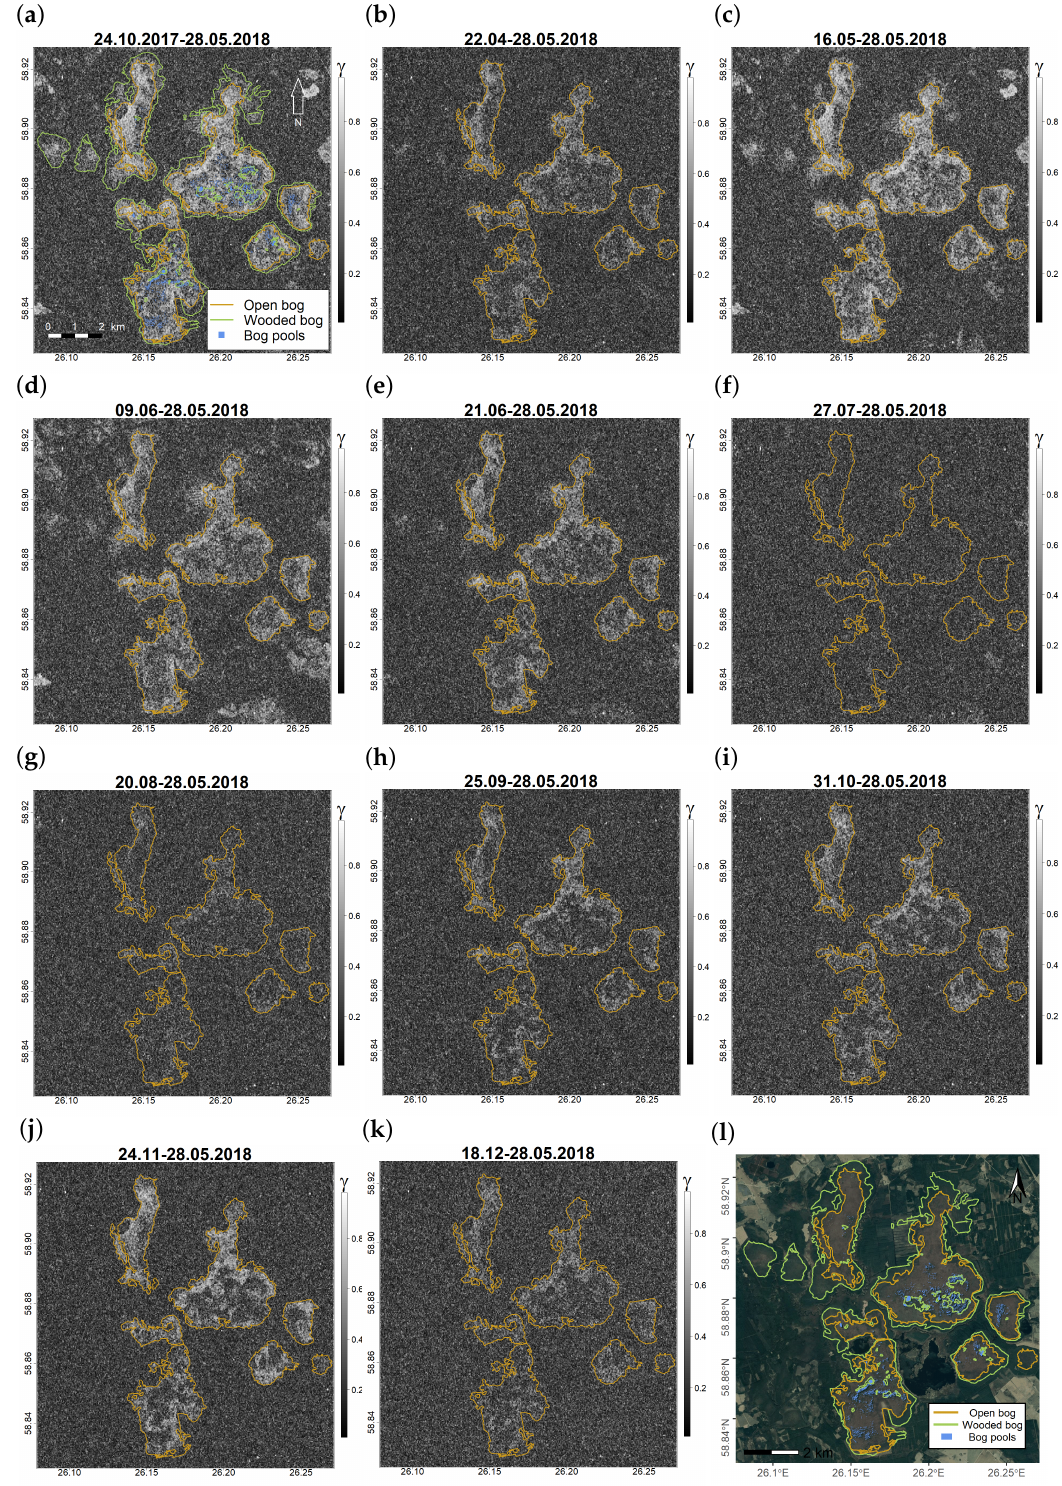
Figure 2. Long term InSAR coherence ( | γ | ) in Endla mire complex from 24 October 2017 to 18 December 2018 ( a – k ) related to a single master image (28 May 2018) and an optical satellite image of the area in relation to land cover types ( l